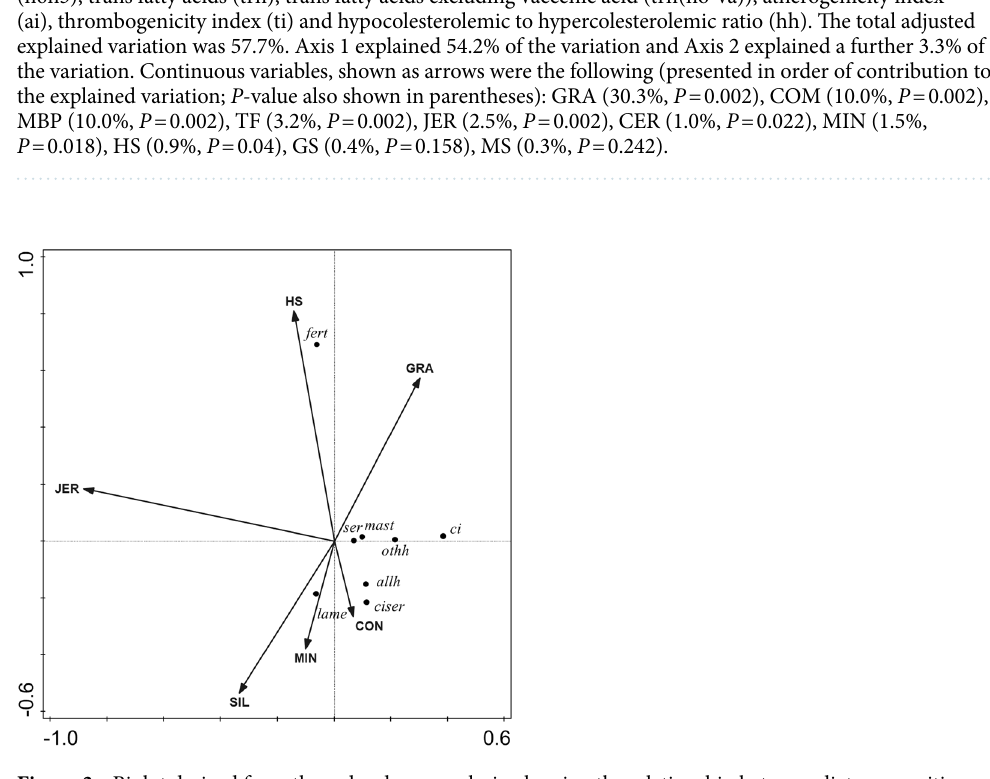
Figure 3. Biplot derived from the redundancy analysis, showing the relationship between diet composition parameters (estimated grazing, GRA; silages (grass silage, maise silage, whole crop silage), SIL; hay/straw, HS; concentrates (moist by-products, cereals, compound feed, dry straights), CON; minerals, MIN) and breed (Jersey, JER), relative to mastitis cases (mast), lameness (lame), other health cases (othh), all health cases (allh), fertility (fert), calving interval (ci), services (ser), and calving to first service interval (cfs). The total adjusted explained variation was 14.9%. Axis 1 explained 14.0% of the variation and Axis 2 explained a further 0.9% of the variation. Continuous variables, shown as arrows were (presented in order of contribution to the explained variation and P-value in parentheses): JER (10.9%, P = 0.008), HS (1.6%, P = 0.298), MIN (1.4%, P = 0.314), SIL (0.9%. P = 0.482), GRA (0.2%, P = 0.834), CON (0.1%, P =